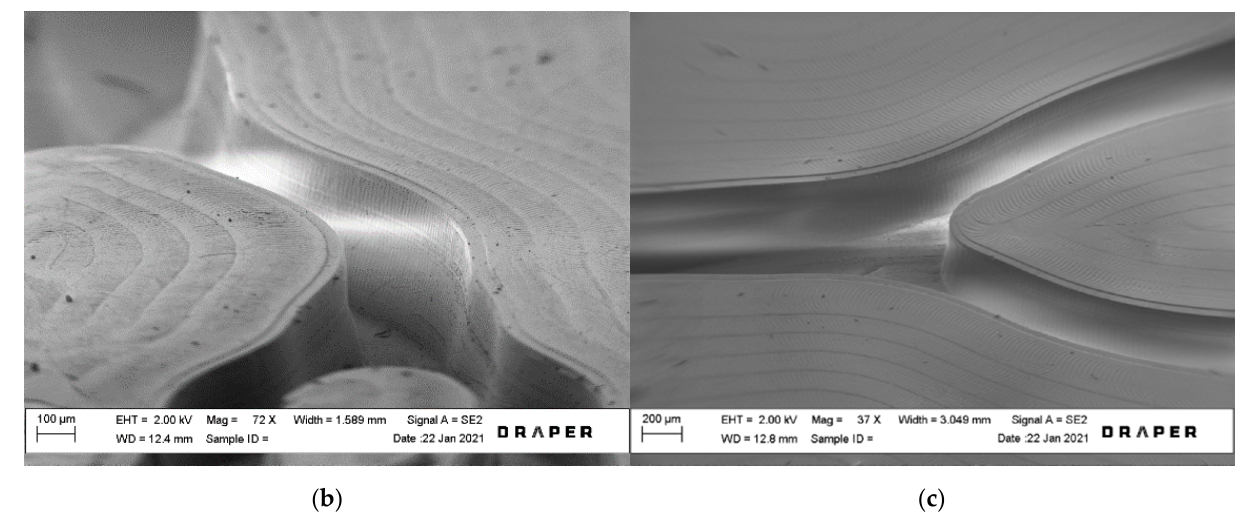
Figure 1. ( a ) Images of fabrication components. (1): Precision machined aluminum master mold section showing blood distribution manifold branching into parallel channel array; (2): Silicone elastomer replica constructed from NuSil; (3): Assembled microfluidic vascular and oxygen layers bonded to cast membrane; (4): SEM image of a cross-section showing blood channels and an oxygen channel separated by a 50-micron gas transfer membrane. ( b ) SEM images of branching channel junction with varying channel depth. ( c ) SEM of smooth branch point in blood channel layer.